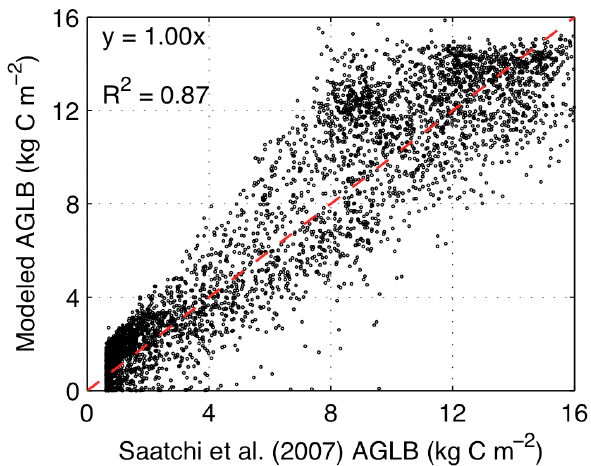
Fig. 1. Comparison of CASA predicted aboveground live biomass (AGLB; leaves and stems) with estimates from Saatchi et al. (2007) based on plot measurements and remote sensing metrics for the Amazon Basin. The red dashed line indicates a 1:1 slope. The regression was forced through the origin.